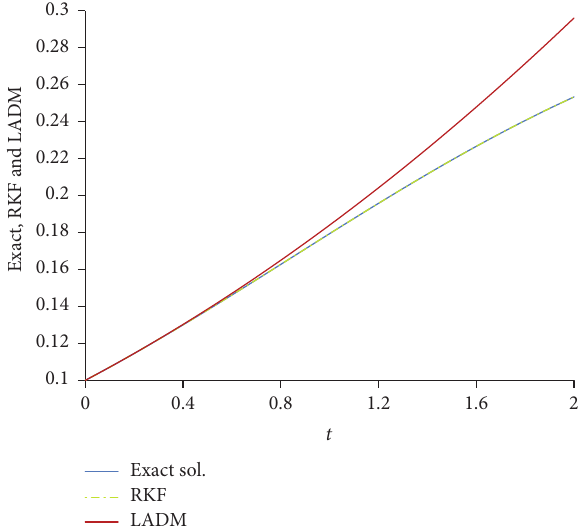
Figure 4: Evaluation between the exact solution and the solutions obtained by using LADM and RKF method for model IV.